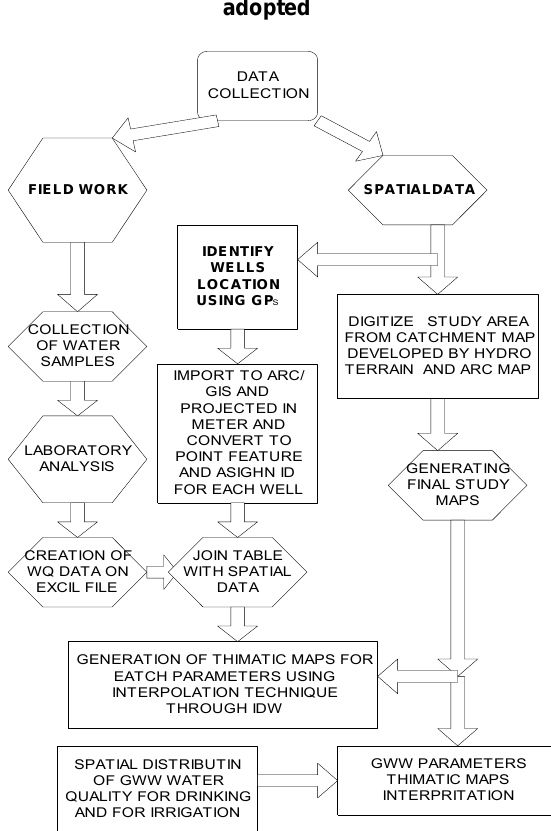
Methodology: Fig (5) Flow chart of the